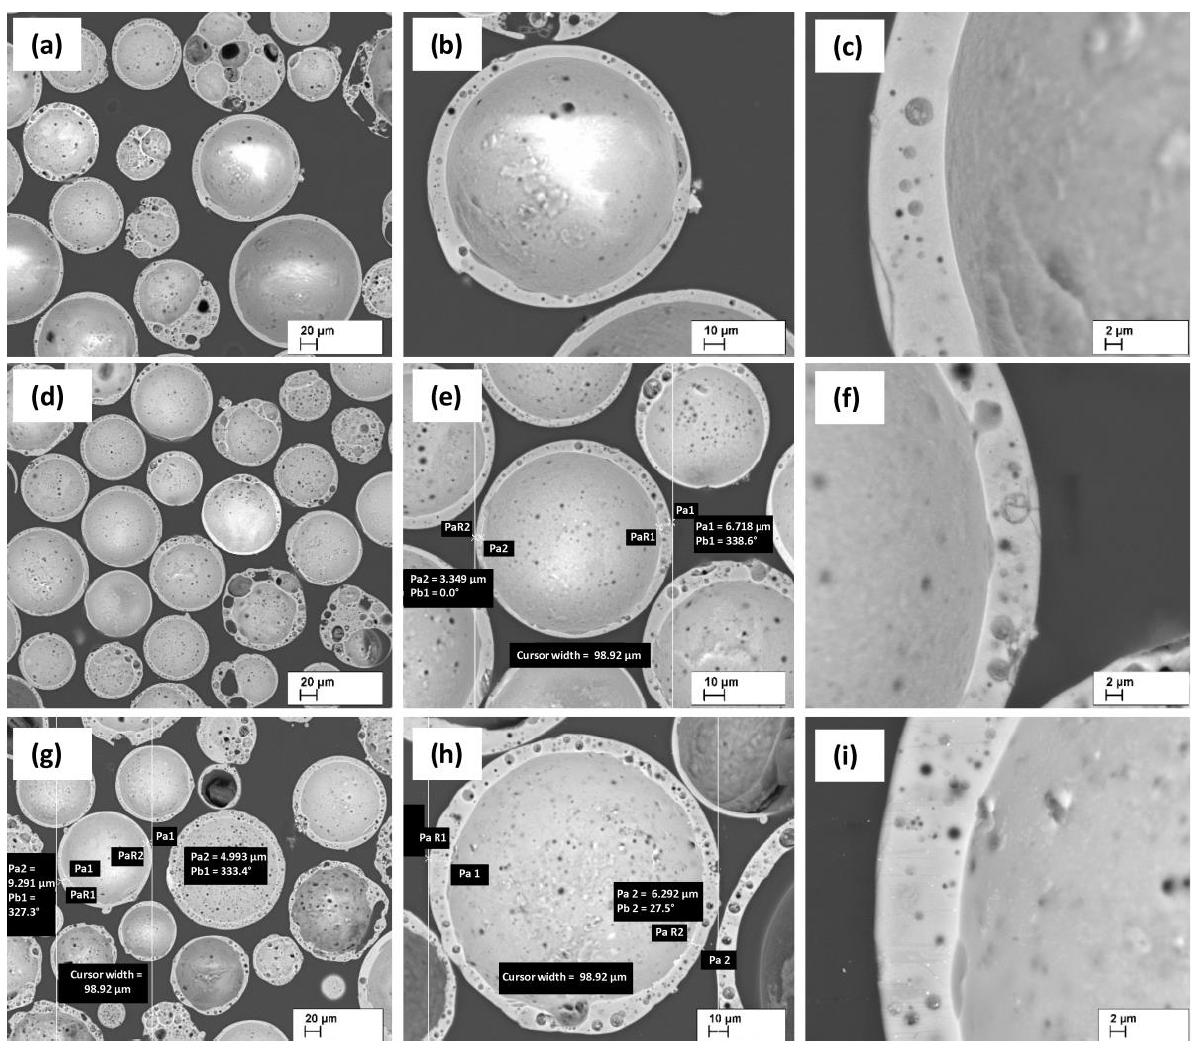
Figure 7. SEM micrographs of CS1 ( a – c ), CS2 ( d – f ), and CS3 ( g – i ) at 200, 500, and 2000 × times magnification, respectively.